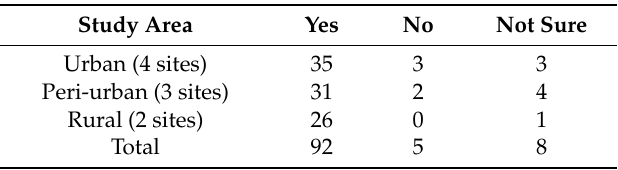
Table 5. Volunteer willingness to participate